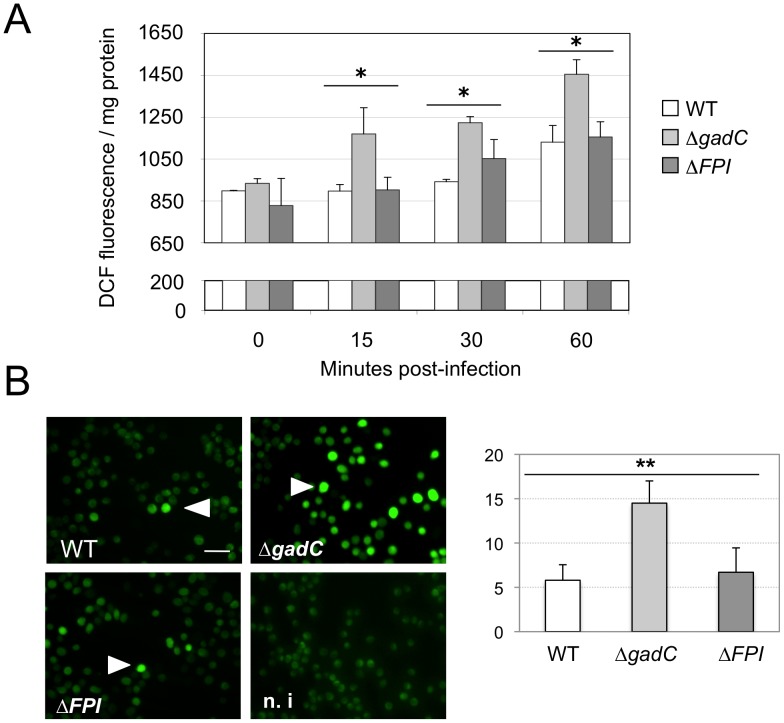
ROS dosage in infected J774.1 cells.(A) ROS dosages. Generation of ROS was measured by the H2DCFDA assay in J774.1 cells infected with wild-type F. novicida (WT), the ΔgadC or the ΔFPI mutant strain. Results, normalized to the protein concentration in each well, are expressed per mg of total protein. The histogram is representative of three independent experiments. (B) Fluorescence microscopy. Left panel: DCFDA levels were also visualized using fluorescence microscopy. J774.1 cells were infected with wild-type (1), ΔgadC (2) or ΔFPI (3) bacteria. Non-infected J774.1 cells were used as negative control (4). White arrowheads indicate increased DCFDA levels. Scale bar is 50 µm. Images represent fluorescence after 1 h of DCFDA treatment. Typical fields were chosen for illustration. Right panel: Quantification of the percentage of fluorescent J774.1 cells. At least 500 cells per experiment were scored for DCFDA labeling after 1 h of DCFDA treatment. Data are means ± standard deviation from three independent assays.